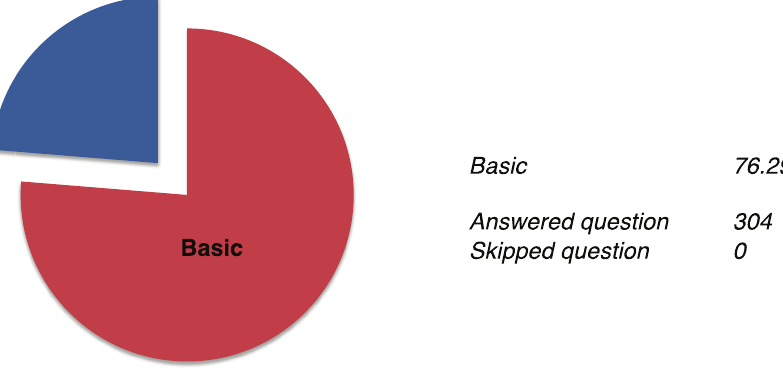
Figure S3. Level of involvement in basic research of the surveyed scientists.